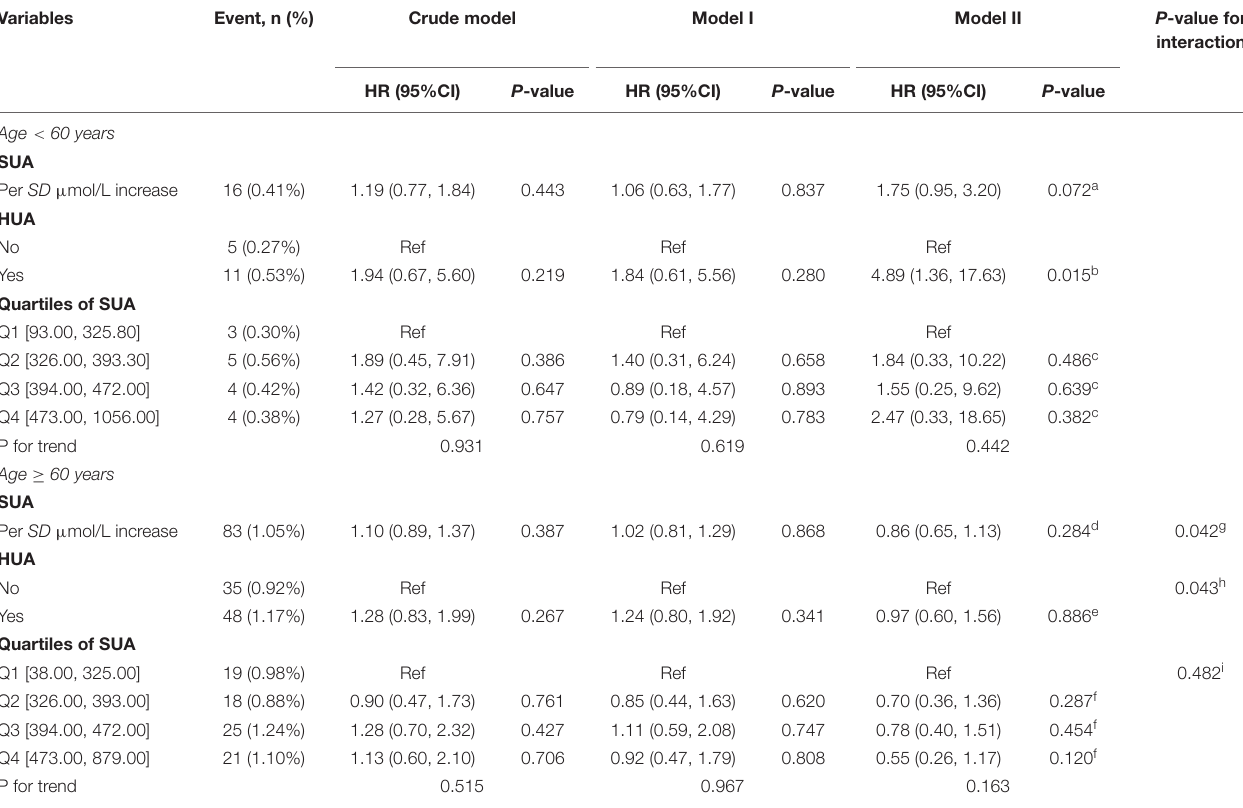
TABLE 4 | Hazard ratios of serum uric acid level categories for total first stroke events by age in different models.